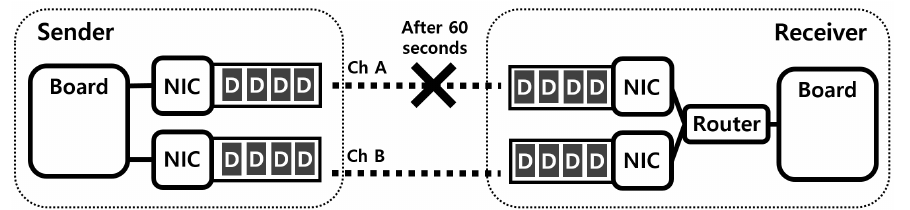
Figure 11. The experiment setup for evaluating packet transmissions in a round-robin fashion. (In order to use MPTCP, it is required that the routing tables in the sender and receiver are configured appropriately and the multiple interfaces are connected to the receiver’s board via a router